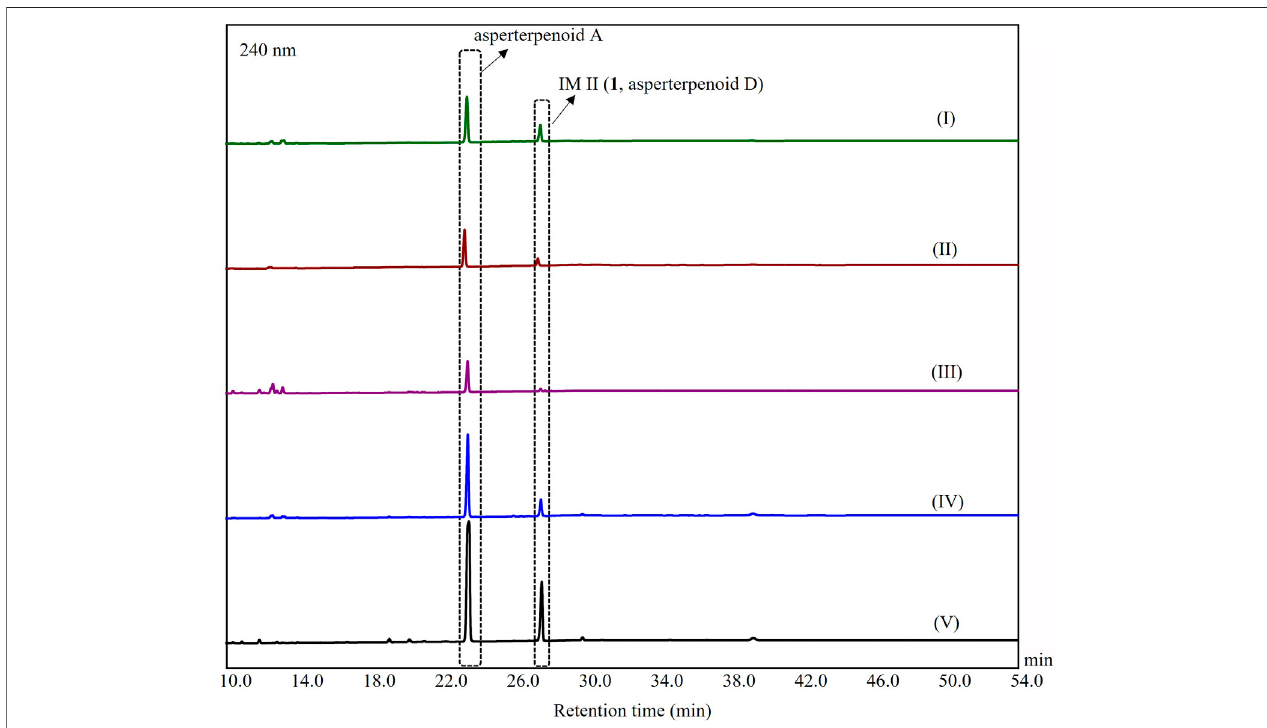
FIGURE4| HPLCanalysisofmetabolitesfrom A.oryzae transformantsharboring astBC .(I)ThestrainwasculturedintheGPYmediumfor3 days,(II)thestrainwas cultured in the PDB medium for 3 days, (III) the strain was cultured in the rice medium for 10 days, (IV) the strain was cultured in the maltose medium for 3 days, and (V) the strain was cultured in the ME medium for 3